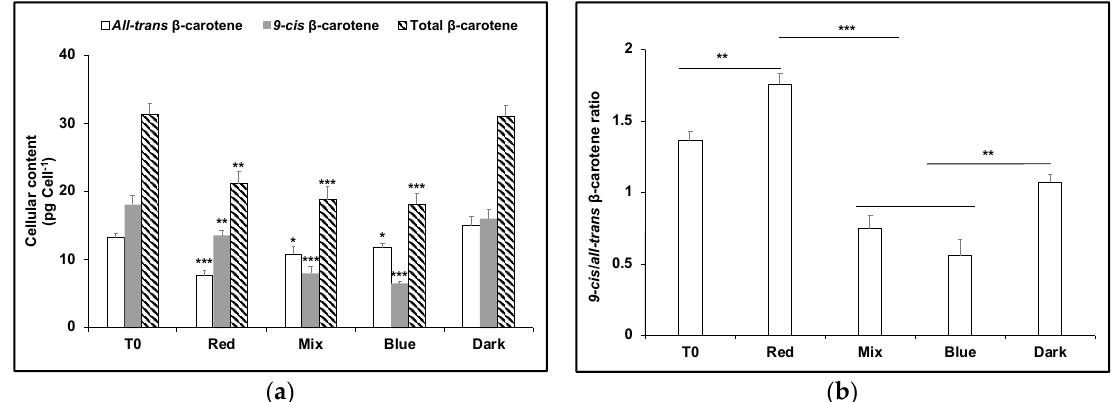
Figure 5. Production of carotenes in D. salina cultures treated with 5 µM norflurazon. ( a ) cellular content of 9-cis β C, all-trans β C and total β C and ( b ) 9-cis / all-trans β C ratio. Cultures were grown for 24 h under white LED light then treated with norflurazon and maintained for a further 48 h under red, blue or a mix of red and blue LED light at 200 µmol photons m − 2 s − 1 or kept in the dark. T0: time point after growth for 24h under white LED light only, before addition of norflurazon. Results were analysed by one way ANOVA with posterior Dunnett’s test compared to T0 and Tukey multiple pairwise-comparisons. Asterisks represent different levels of significance (*** 0 < p ≤ 0.001, ** 0.001 < p ≤ 0.01, * 0.01 < p ≤ 0.05).